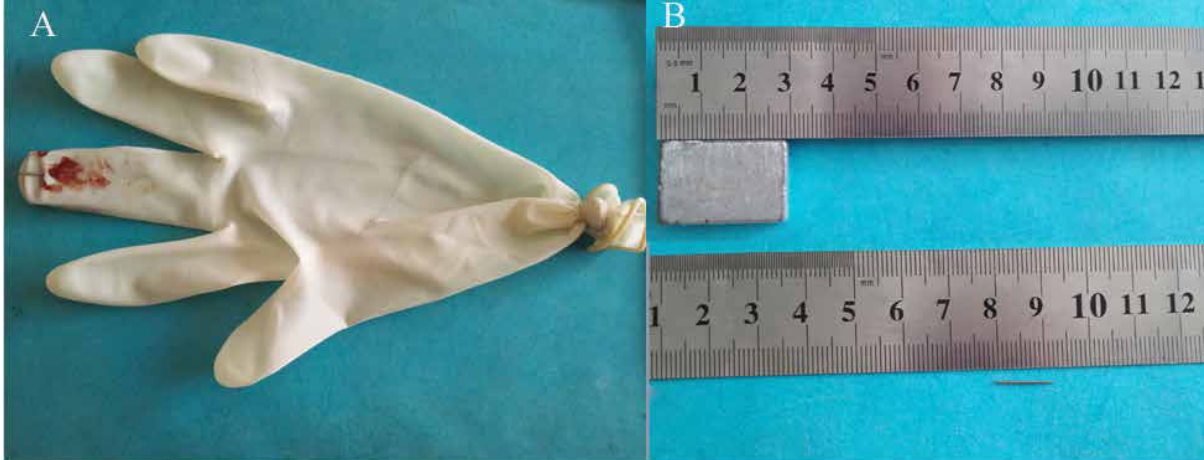
Figure 2: A: the broken needle and the permanent magnet, B: the permanent magnet used in the operation, the length of the broken needle is about 1,2 cm.